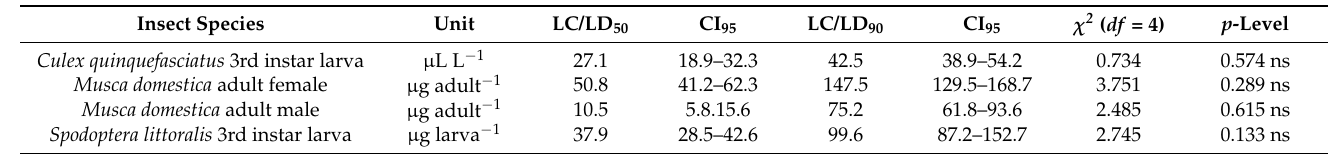
Table 2. Lethal concentrations (LC) and lethal doses (LD) of Ridolfia segetum flower essential oil against three key insect pests and